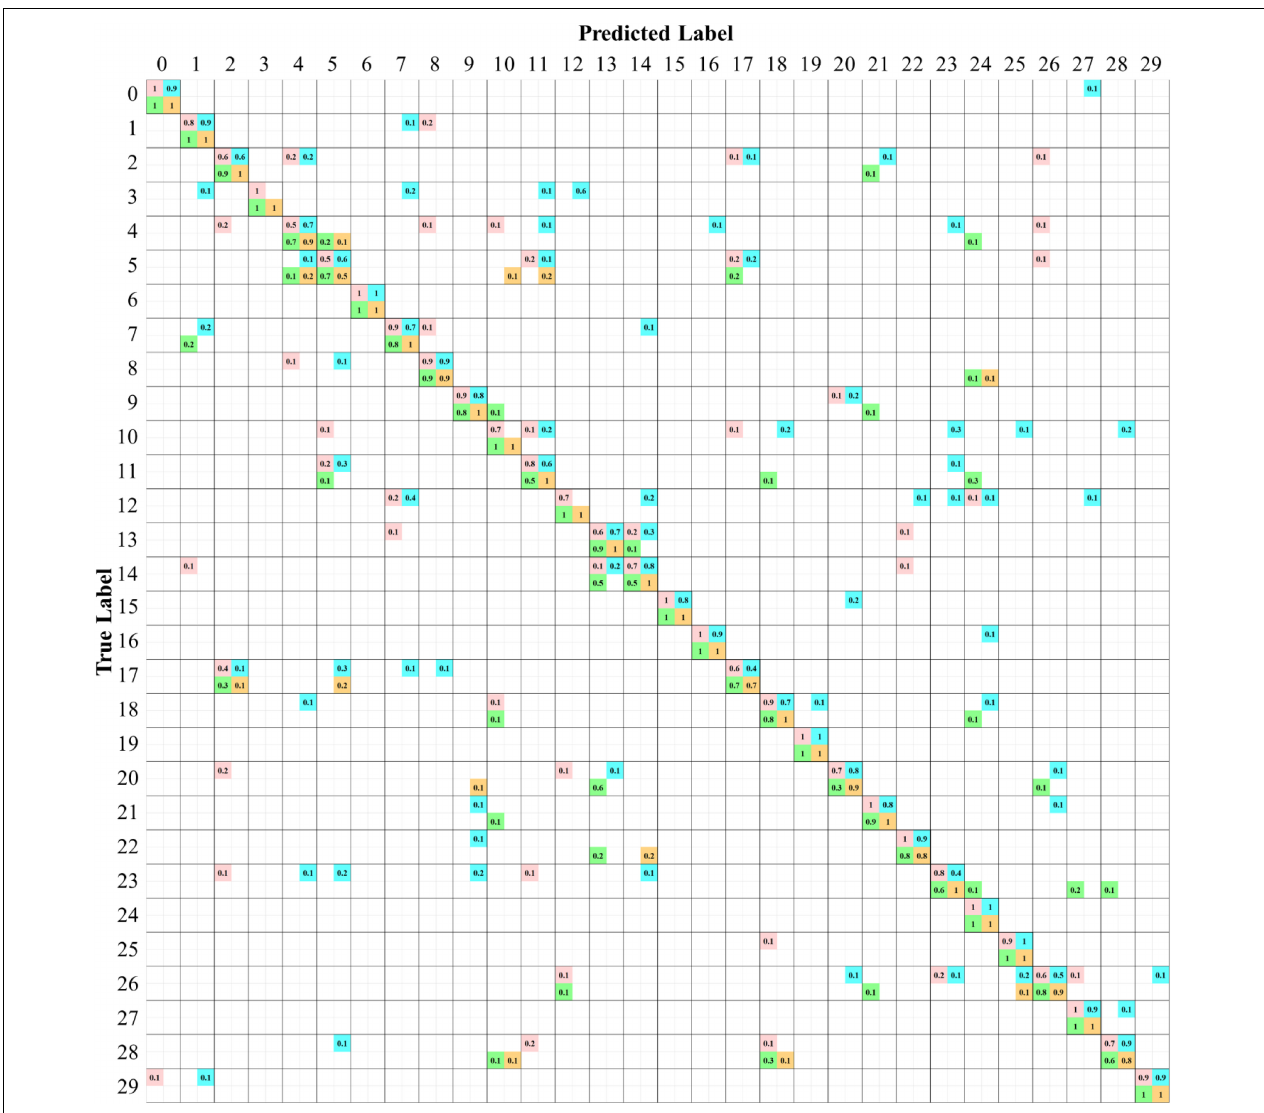
FIGURE 9 | Confusion matrices of species classification of the four CNN models using the six bands of the RGB+NIR dataset. The values in each diagonal entry are the probability of a species image being classified correctly. The numbers in upper/lower off-diagonal entries are the omission rate/commission rate. The numbers highlighted are for the models AlexNetr (pink), GoogLeNet (cyan), VGGNetr (green), and LtCNN